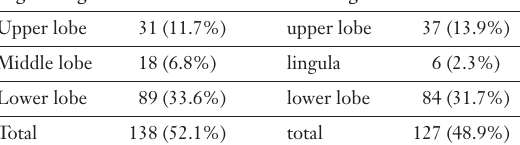
Localisations of 265 intrapulmonary cystic lesions.